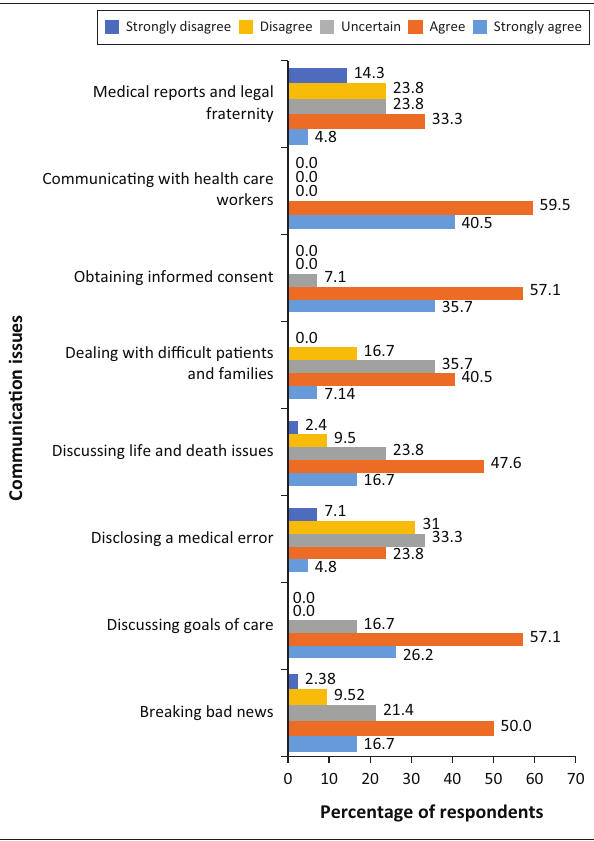
FIGURE 4: Neurology specialists’ self-perceived competency in dealing with communication issues in